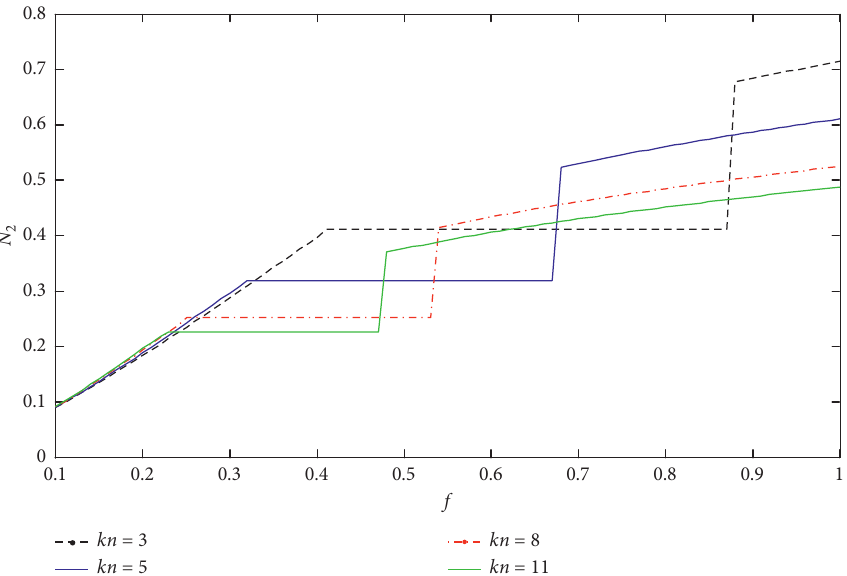
� 0 . 8 ; λ � 0 . 3 ; kn � 5 ; f � 0 . 5. 1 2